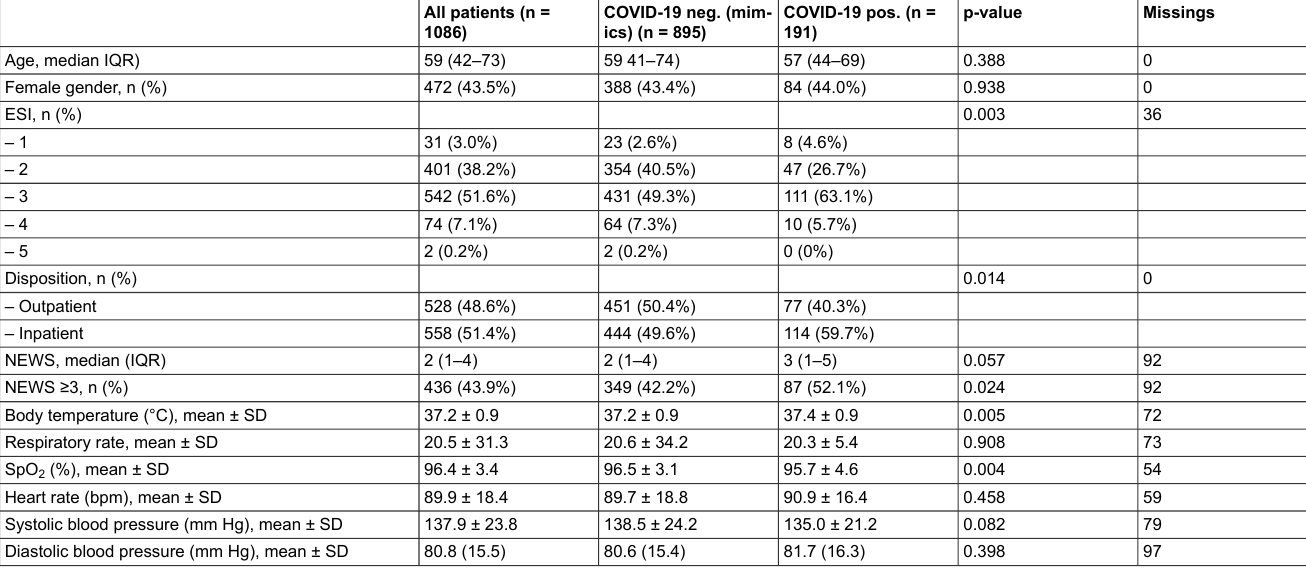
Table 2: Baseline characteristics of all patients clinically suspected of COVID-19 (n = 1086).